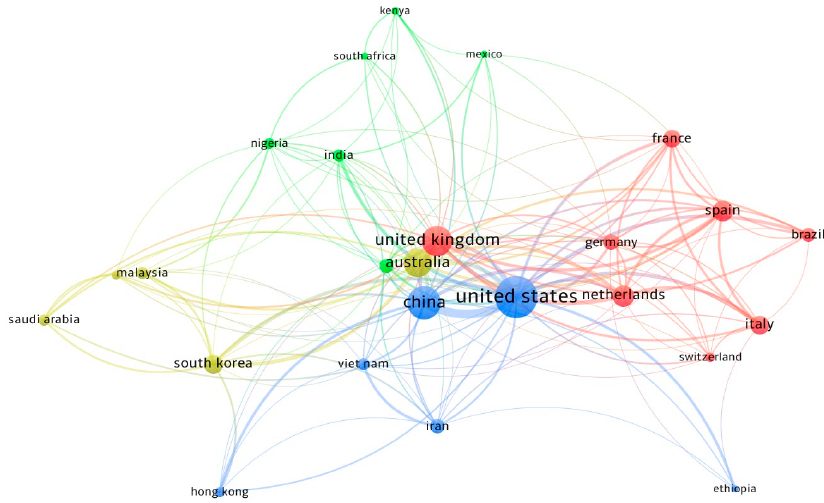
Figure 13. Network visualization map of country co-authorships in the DF field. Countries with a minimum of 10 published and cited articles were included. The map includes 25 countries in 4 clusters. Total link strength of the top 5 countries are as follows: USA = 137, China = 97, United Kingdom = 83, Australia = 76, Netherlands = 52.